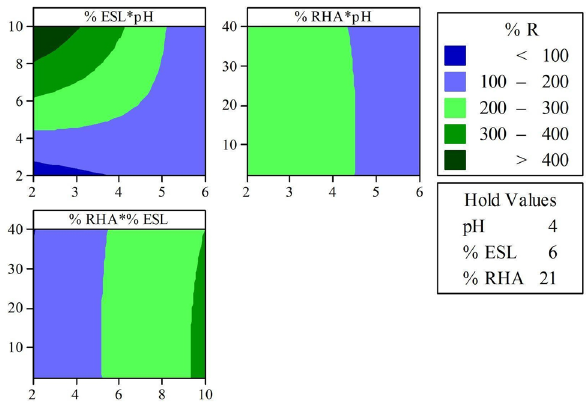
Figure 5. Contour surface of the experimental design of Mixture 1.